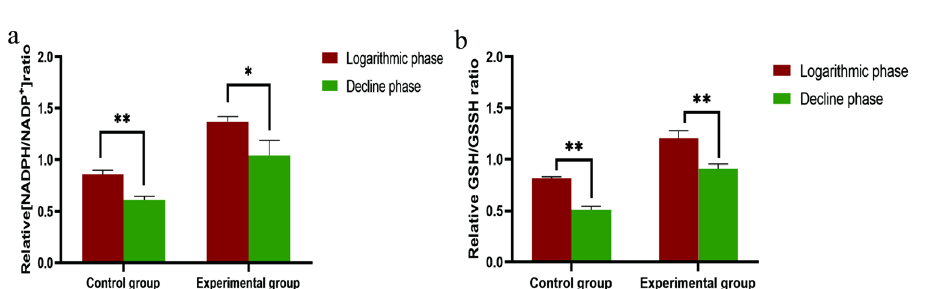
Figure 5. The activity of PHGPx in the logarithmic and decline phases. ( a ) The NADPH/ NADP + ratio of T. tetrahymena in the two phases between control and experimental groups ( b ) The GSH/GSSH ratio of T. tetrahymena in the two phases between control and experimental groups Symbols: * p < 0.05, ** p < 0.001, ns, not significant